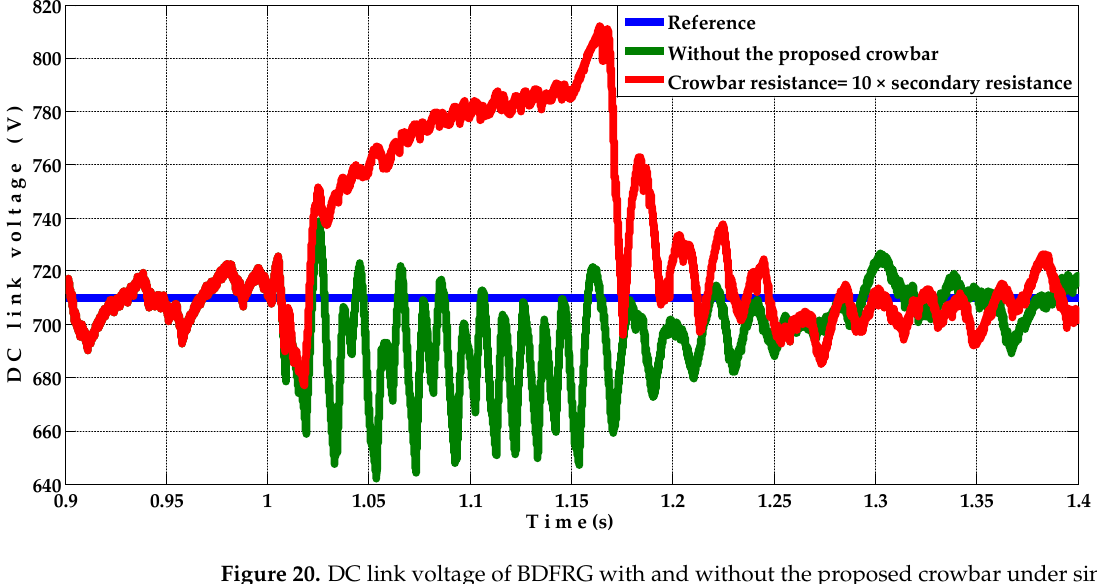
Figure 20. DC link voltage of BDFRG with and without the proposed crowbar under single-line to ground fault occurrence.